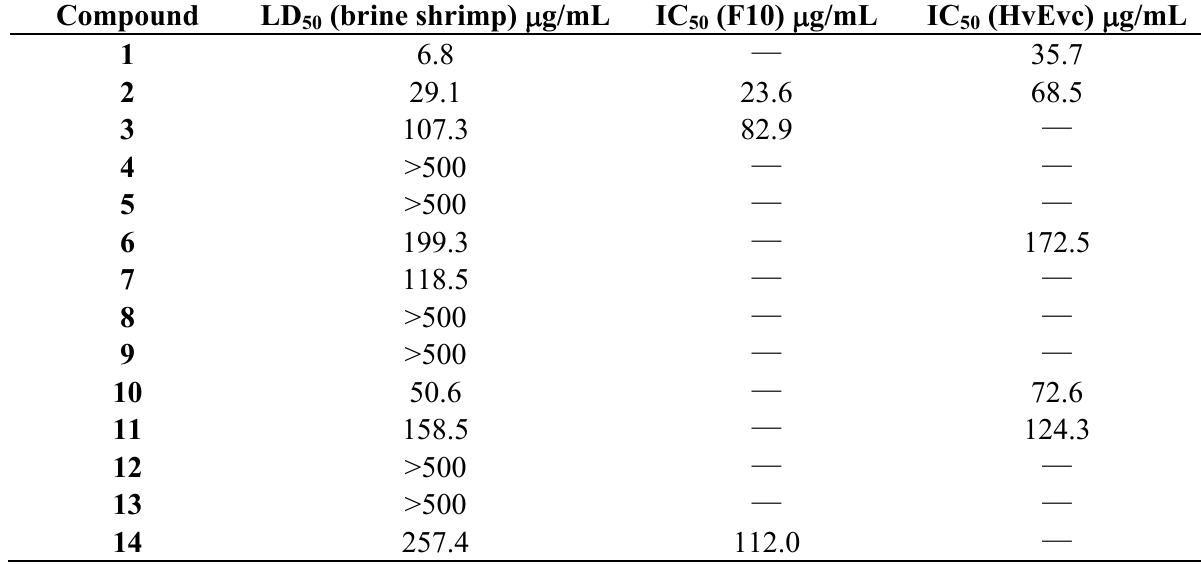
Table 2. The LD values of compounds 1–14 against brine shrimp larvae and the IC 50 values of all compounds against mammary cancer (F10) and lung cancer (HvEvc) cell lines.